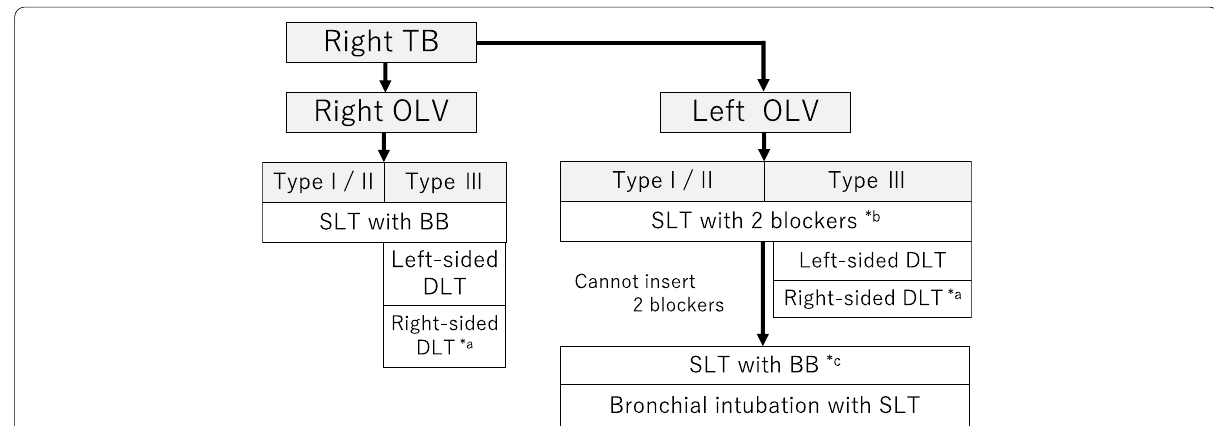
Fig. 4 Strategy for OLV in patients with a right TB. *a: Using a right-sided DLT with a shortened bronchial side tube design. *b: Dual BB technique; BB (e.g., Arndt endotracheal blocker or uninvent bronchial blocker) and Fogarty catheters are inserted inside and outside the SLT, respectively, to occlude the right main bronchus and right TB [6, 11]. *c: Selective BB; since the right upper lobe is not deflated by this technique, this technique is dependent on the type of surgical procedure being performed. BB, bronchial blocker; DLT, double-lumen endotracheal tube; OLV, one-lung ventilation; SLT, single-lumen endotracheal tube; TB, tracheal